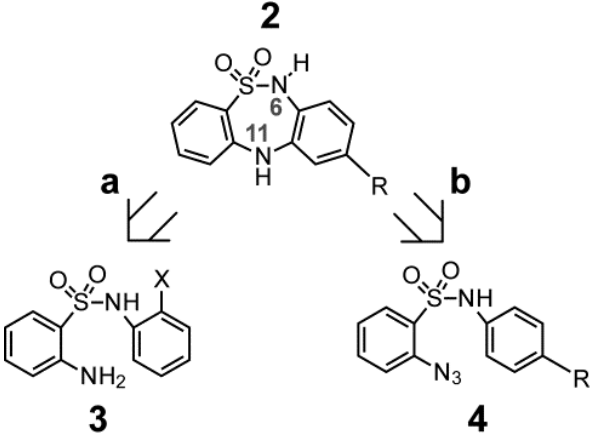
Figure 2. Retrosynthetic analysis of the non-substituted DBTDs. ( a ) Classical method for obtaining 2 by the Goldberg methodology; ( b ) Obtaining 2 from an aryl azide.